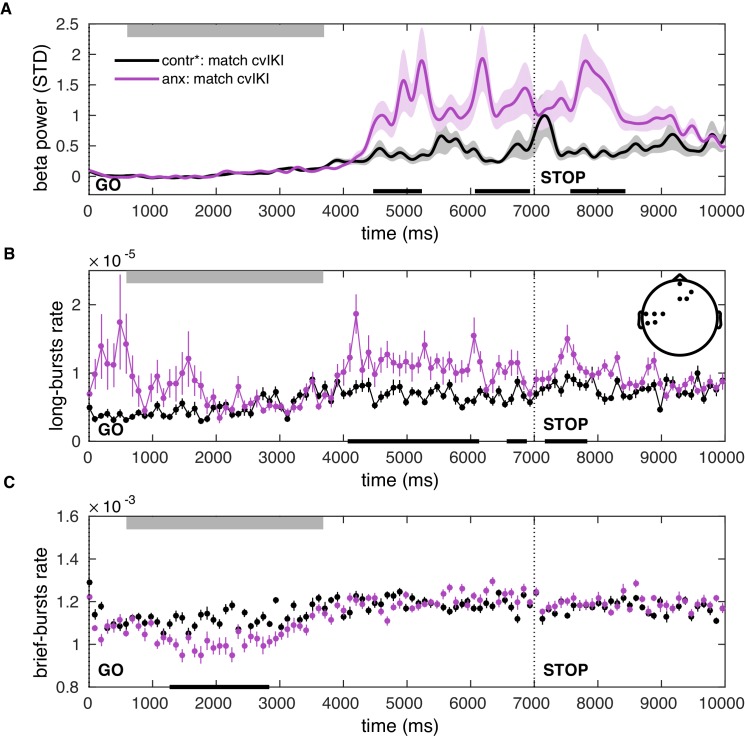
Post-movement increases in the beta-band amplitude and burst rate can be explained by state anxiety after matching participants on temporal variability.(A–C) A separate control analysis was carried out to determine the influence of the anxiety manipulation alone on the beta PSD and burst rate properties, after controlling for changes in motor variability (cvIKI). Panels (A–C) are similar to Figure 8A, C, but for a comparison between anx1 and participants from an extended control group (contr*, including control and anx2 participants, who were not affected by anxiety during the initial exploration block), after matching them in motor variability. Significant between-group differences are denoted by the black bar at the bottom (PF⁢D⁢R<0.05,Δ=0.81,C⁢I=[0.72,0.90]). This analysis revealed effects in the same windows as the primary between-group analysis shown in Figure 8. Mean power and burst rate in panels (A–C) are estimated across the significant sensorimotor and prefrontal electrodes shown in the inset in panel (B).